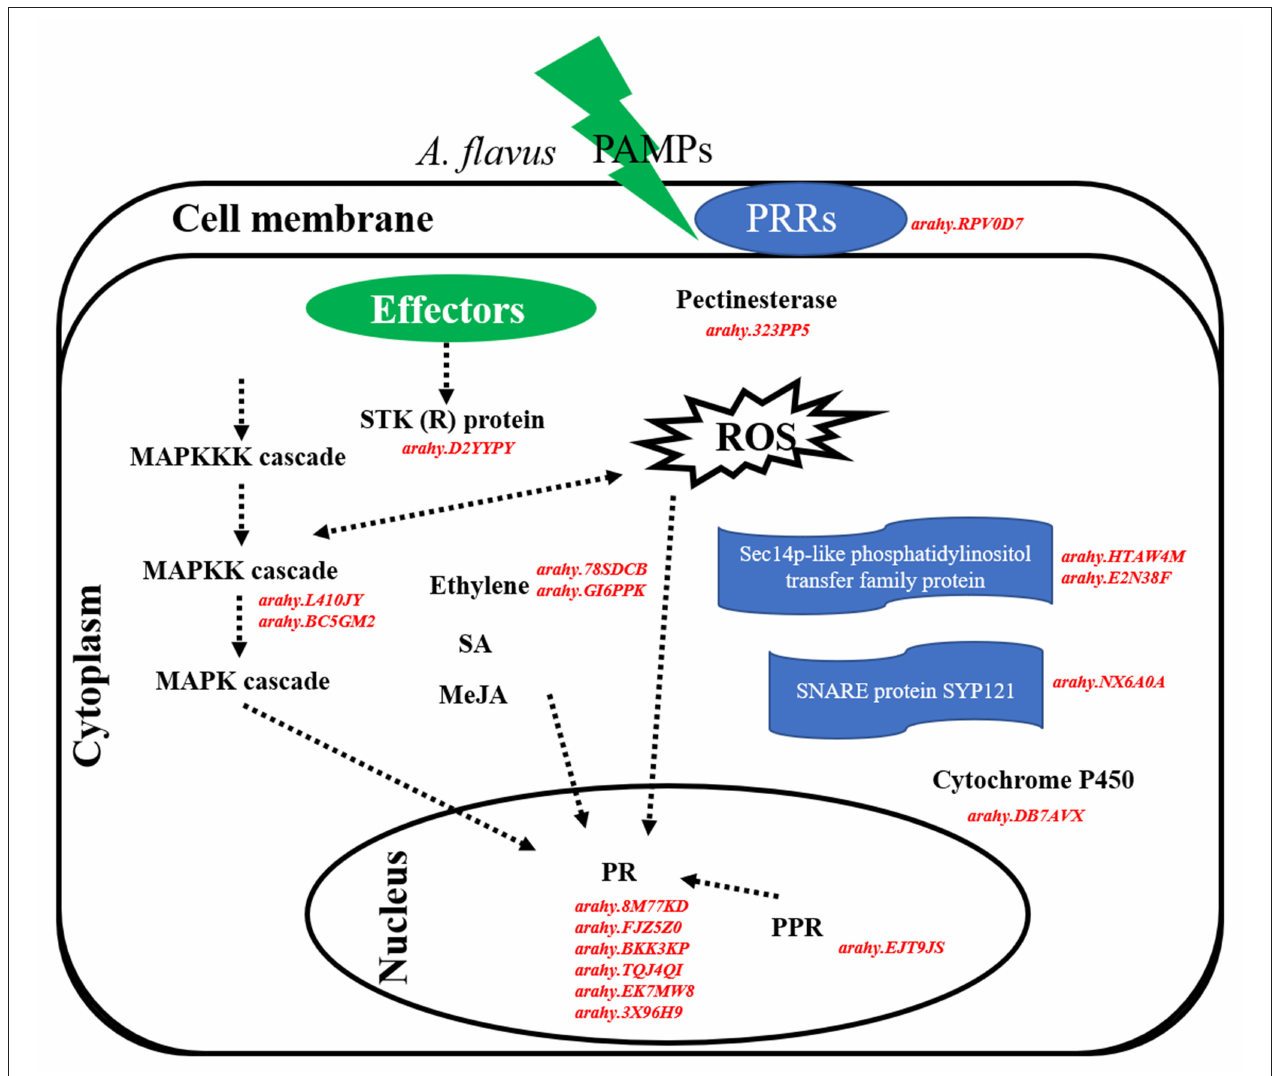
FIGURE 9 | Hypothetical pathways and reactions present in response of peanut seeds to A. flavus at the gene expression level. The components represented in red color are hub genes resistance to A. flavus stress identified in our study. In brief, PAMPs of A. flavus combined with PRRs at the cell membrane and activate PTI response in peanut to limit the growth and reproduction of A. flavus . Subsequently, effectors of A. flavus were released into the cell and were recognized by R proteins (STK), thus triggering ETI response. In this defense responsive mechanism, PR10, pathogenesis-related proteins; ACO1, 1-aminocyclopropane-1-carboxylate oxidase; MAPK kinase, STK, serine/threonine kinase, PRRs, cytochrome P450, SNARE protein SYP121, pectinesterase, phosphatidylinositol transfer protein, and PPR protein are expressed during A. flavus infection process and play main role in the resistance